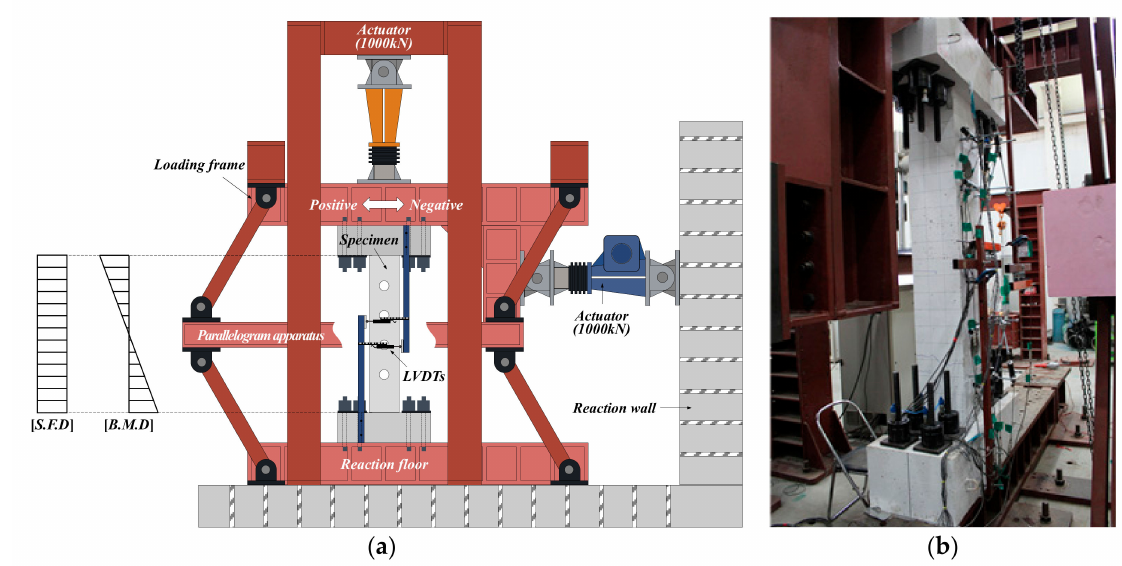
Figure 3. View of test setup: ( a ) schematic of test setup; ( b ) photo of experimental setup.